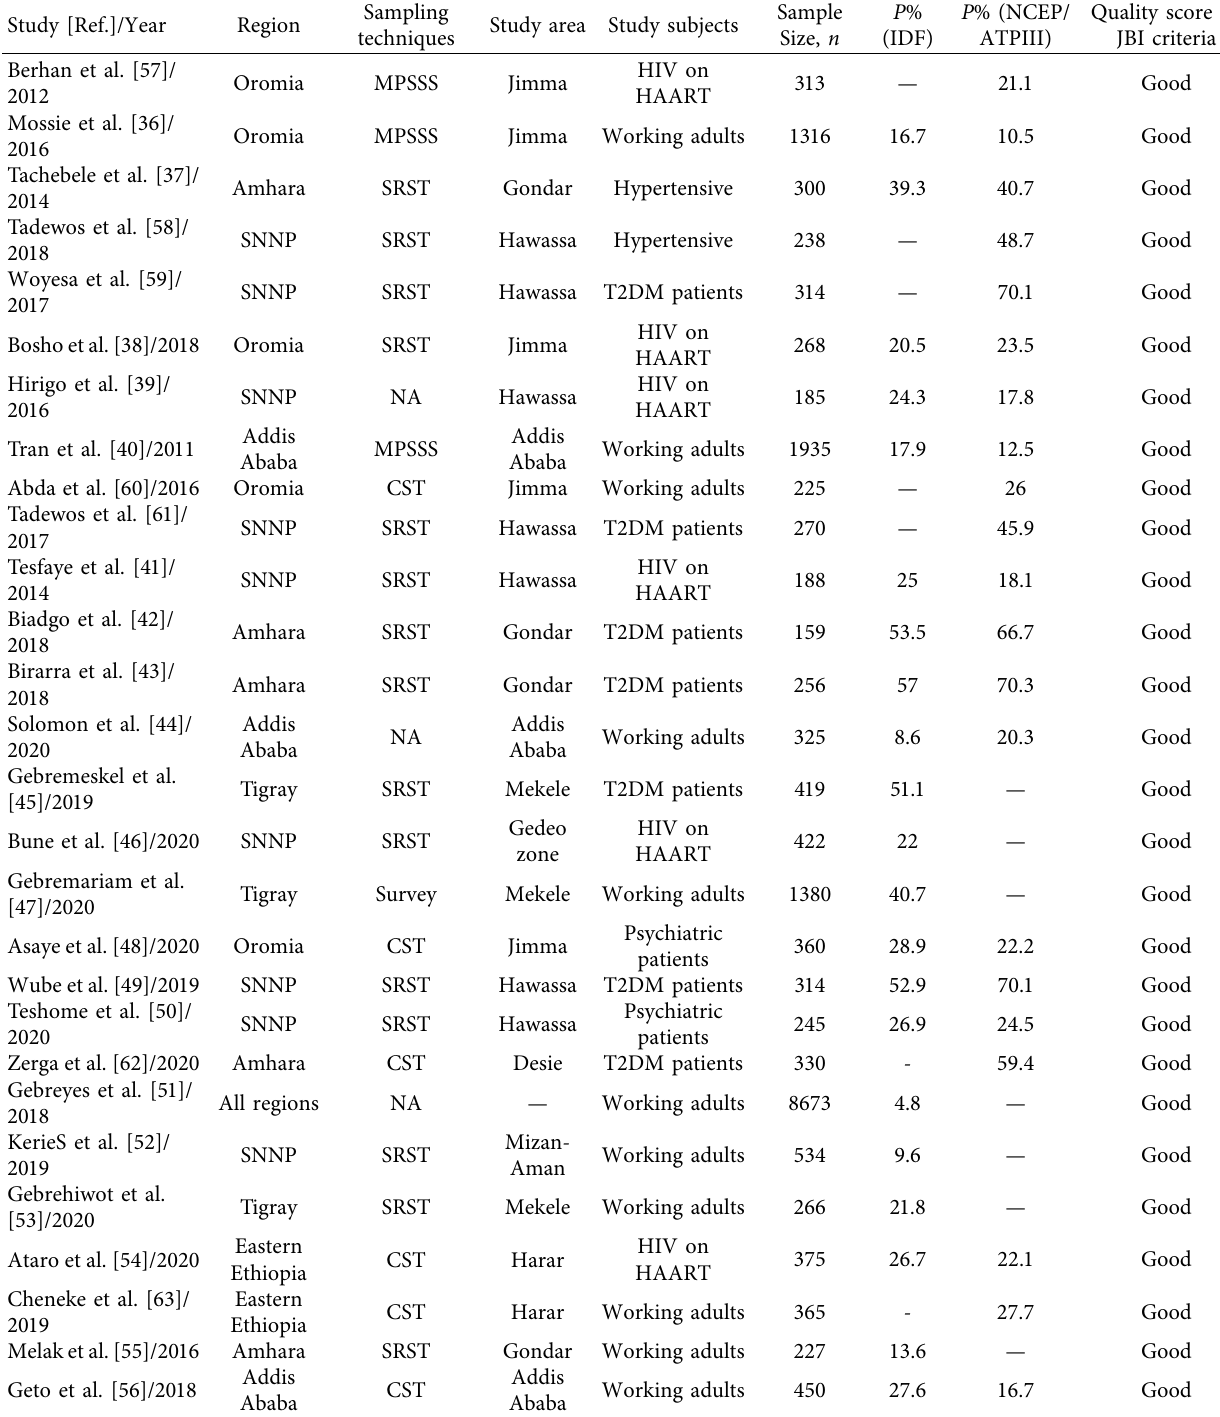
Table 3: Baseline characteristics and outcomes of the included studies (n �